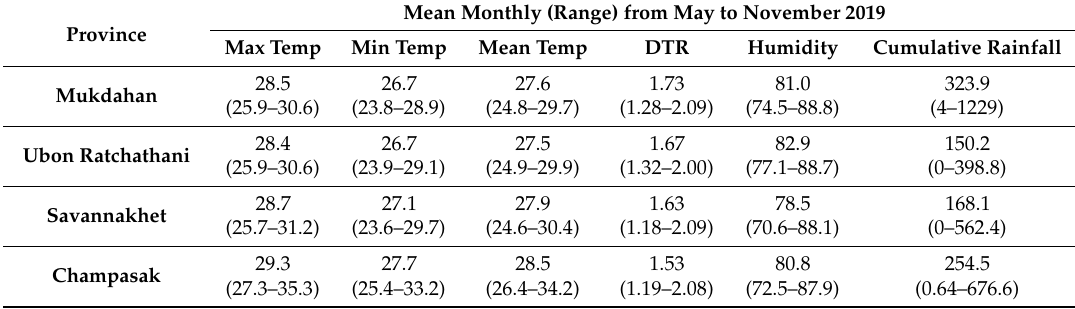
Table 4. Mean monthly values (and maxima and minima) of temperature ( ◦ C), relative humidity (%) and cumulative rainfall (mm) for the four provinces. DTR—Diurnal temperature